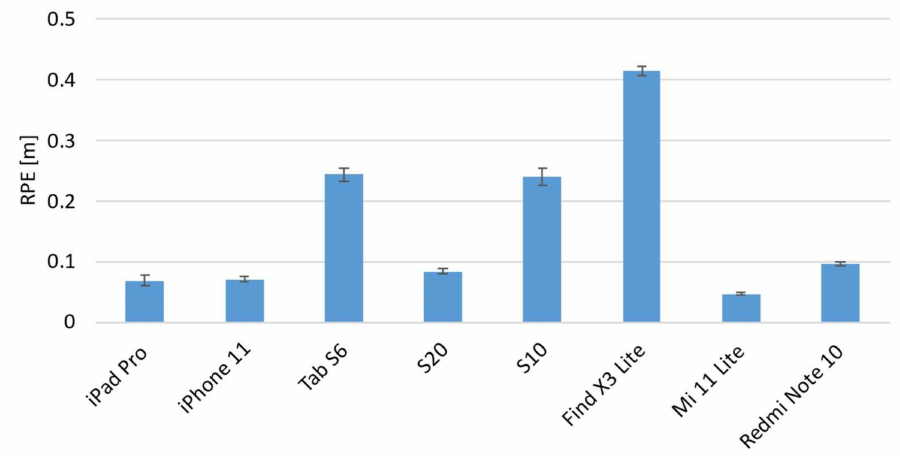
Figure 11. Relative Pose Error (RPE) evaluation results related to the eight-shaped path.